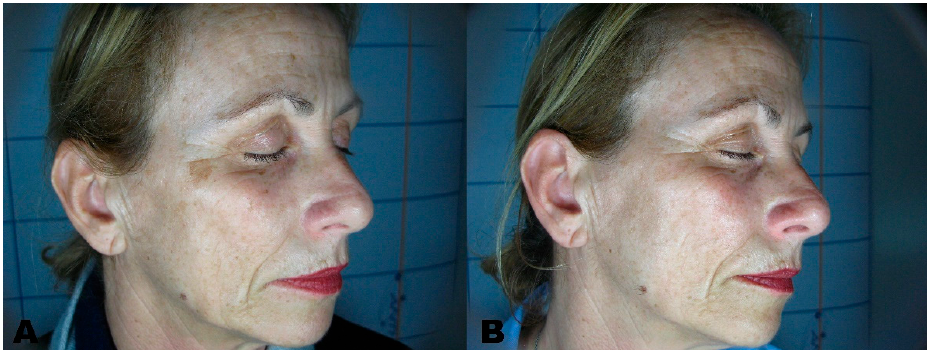
Figure 1. ( A ) Solar Lentigo before treatment. ( B ) region three months after the last session.